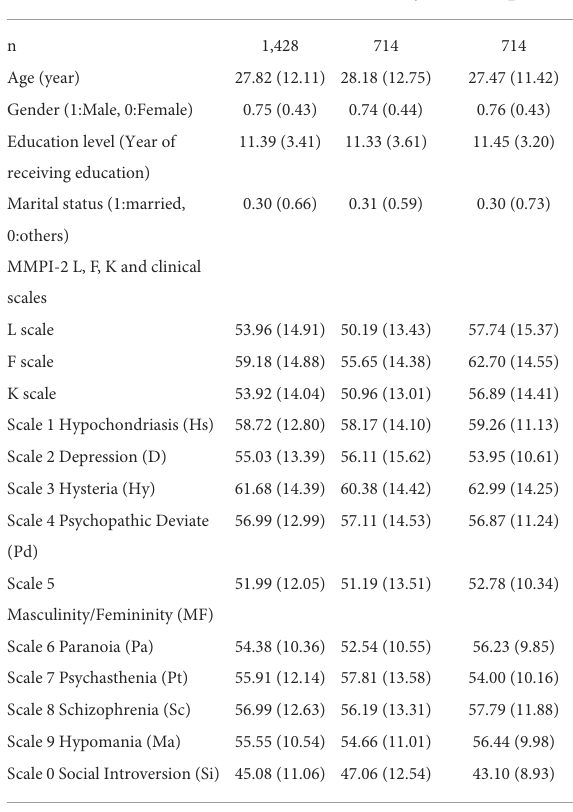
TABLE 1 Demographics of participants included in this